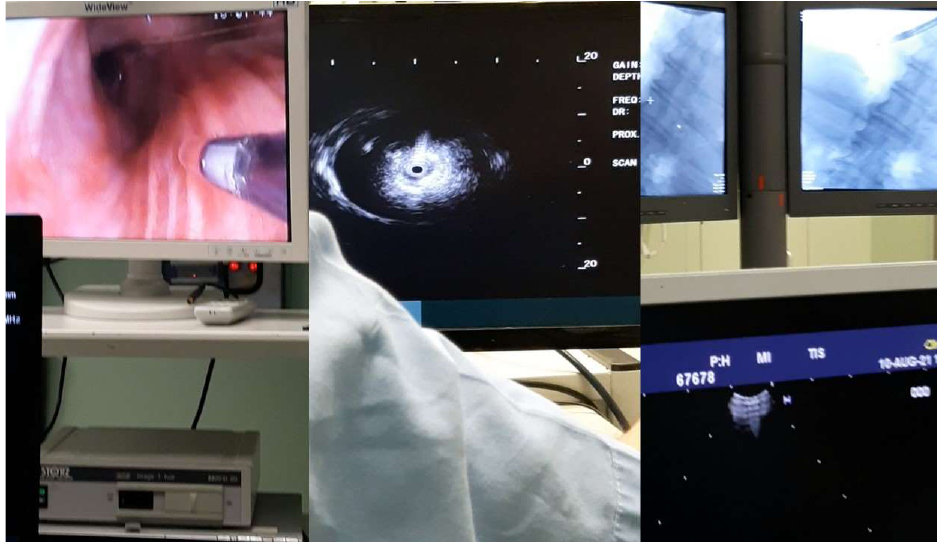
Figure 1. Left and middle: the Fuji radial probe; right: image from the C-Arm up and down image from the convex probe (PENTAX).